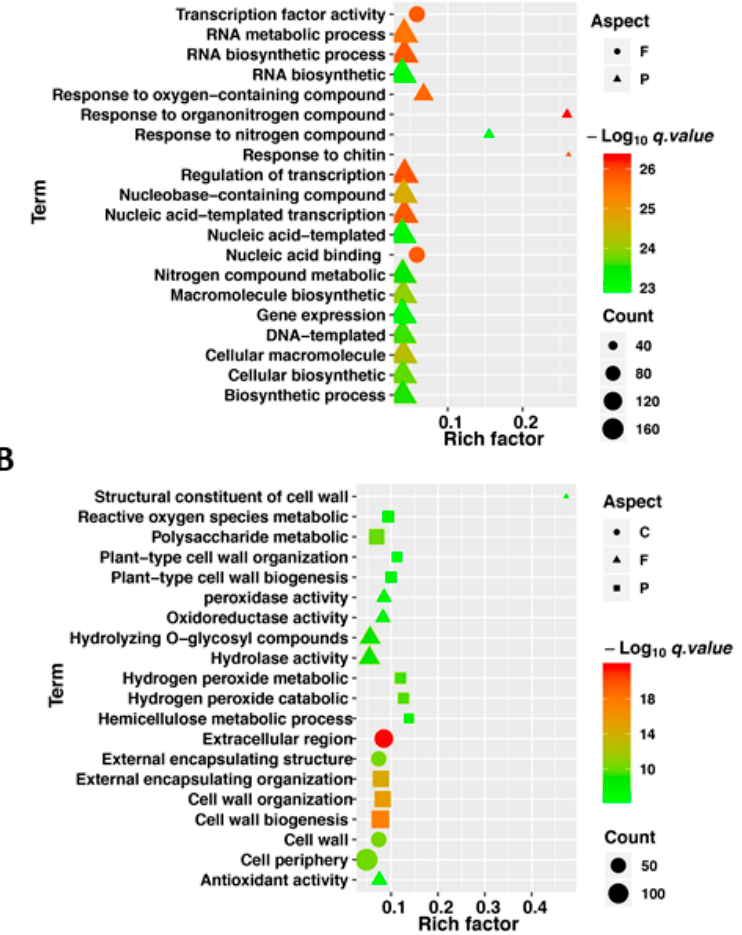
Figure 5. Gene ontology (GO) analyses of up- and down-regulated genes responding to flooding. ( A ) GO enrichment analysis of up-regulated DEGs. ( B ) GO enrichment analysis of down-regulated DEGs. In ( A ) and ( B ), GO enrichment was based on cellular component (C), molecular function (F) and biological process (P). The horizontal axis value shows enrichment factor ( q < 0.05). All GO terms are displayed as –log 10 (Fisher’s exact test q value).